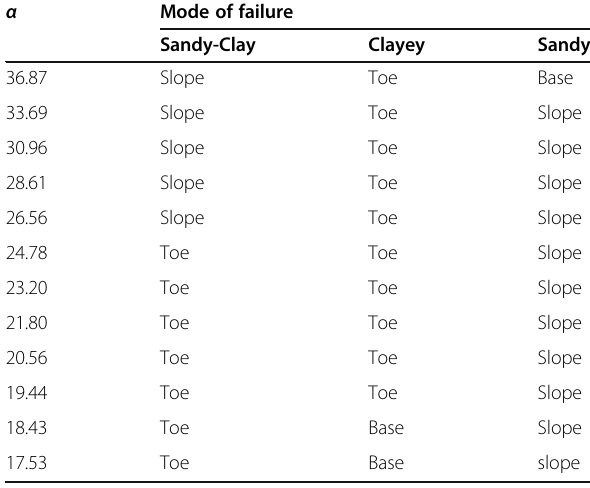
Table 2 Mode of failure based on height Slope height